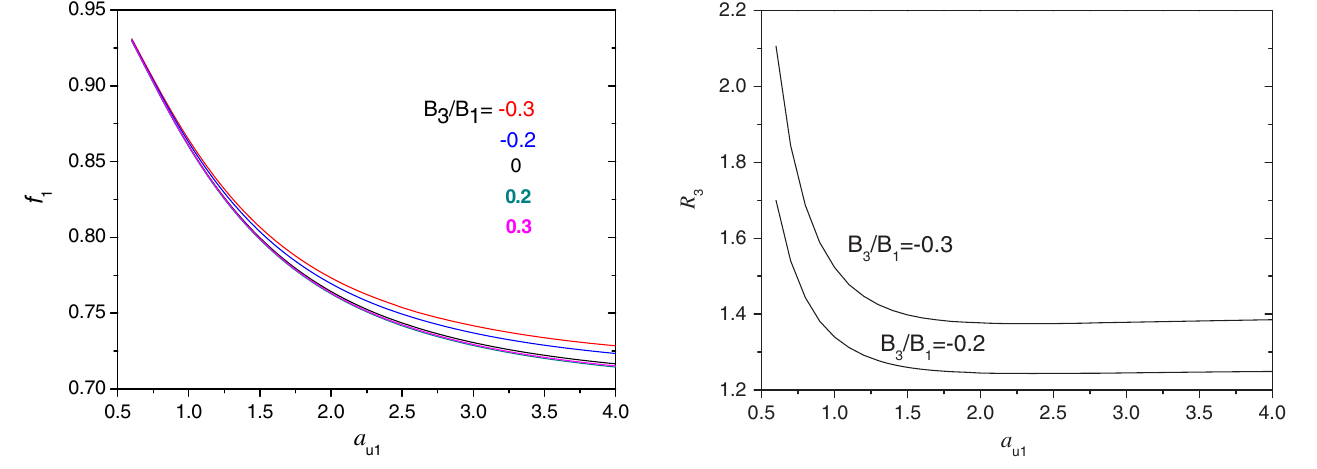
FIG. 4. The enhancement of the FEL harmonic radiation with B 3 .